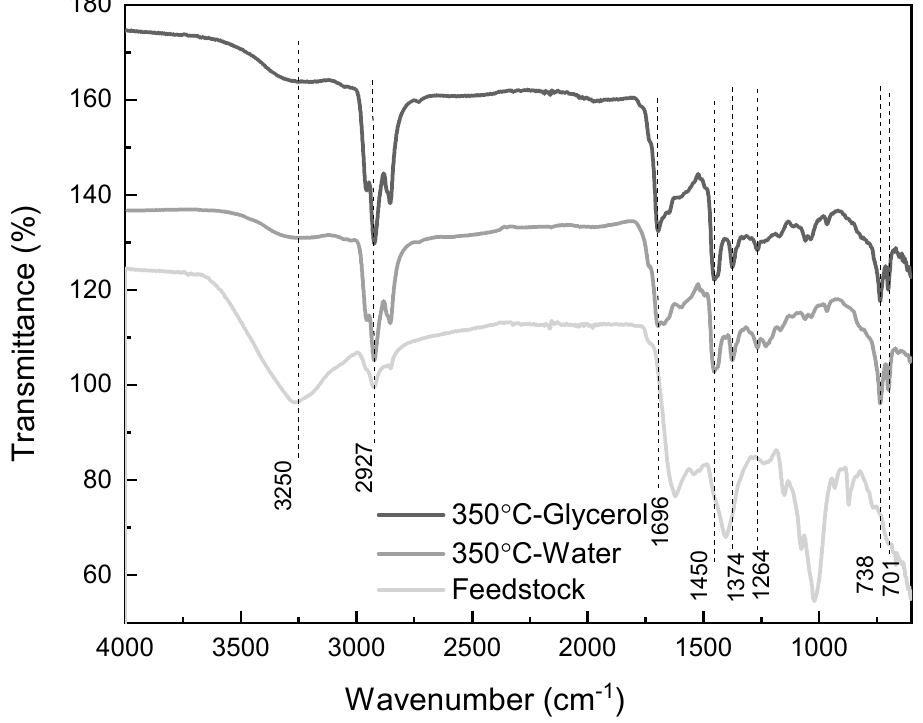
Figure 6. FTIR spectra of algal feedstock and biocrude products from HTL treatment of Tetraselmis sp. at 350 °C—with and without the inclusion of 10% glycerol as co-solvent.